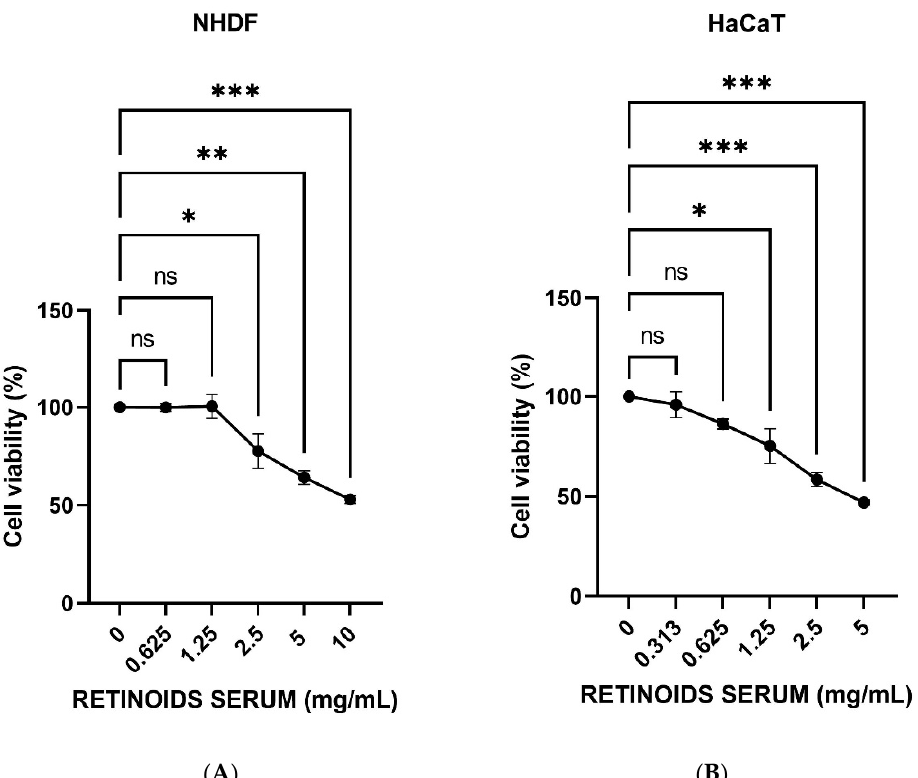
Figure 1. Cell viability expressed as a percentage (mean ± SD) after 24 h of treatment on NHDF ( A ) and HaCaT cells ( B ) after treatment with the RETINOIDS SERUM compared to the control (untreated cells) (n = 3, replicates = 3). Values of * p < 0.05 and ** p < 0.01 and *** p < 0.001 were considered statistically significant.